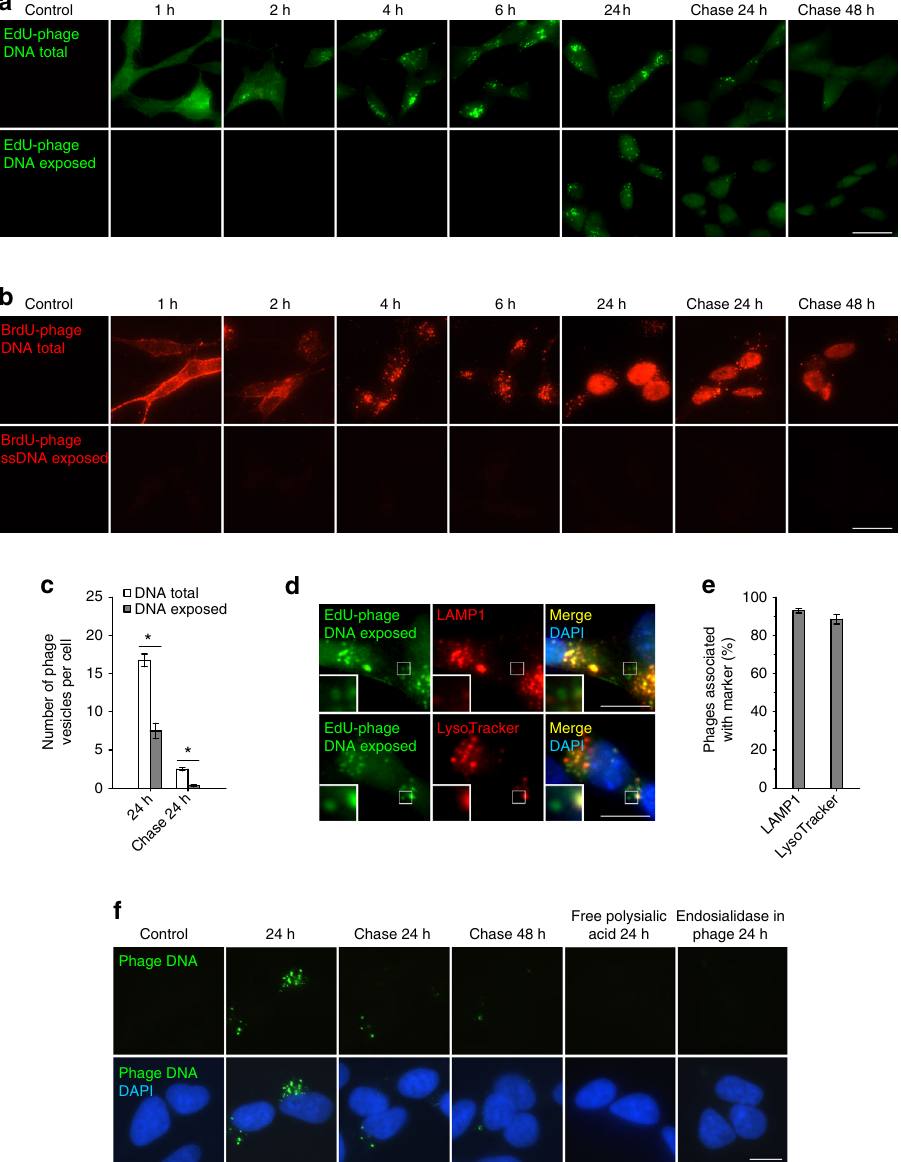
Fig. 6 Time course of the exposure of phage DNA inside the cell. a , b Internalization of DNA-labeled PK1A2 phages into cultured kSK-N-SH cells at 37°C. EdU ( a ) or BrdU ( b ) labeled phages (green and red, respectively) were detected under the conditions showing total DNA or exposed DNA as described in Methods. EdU staining reveals DNA irrespective of strand form, the BrdU method reveals DNA in single-strand form. Representative images from three biological replicates are shown. c Quanti fi cation of phage vesicles positive for EdU at 24h and after subsequent chase for 24h (each vesicle may contain several phage particles). At least 100 cells were quanti fi ed for each condition. Results are expressed as mean ± s.d. of three independent experiments. The asterisks mark P -value of < 0.005 as calculated by Student ’ s t -test. d Association of EdU-labeled phage clusters with lysosomal compartments. The cells were incubated with phages (green) for 24h at 37°C to reveal exposed phage DNA and LAMP1 (red) or LysoTracker (red) as in Figs. 4b and 6a. Nuclei were stained with DAPI (blue). Representative images from two biological replicates are shown. e Quanti fi cation of EdU-labeled phage vesicles positive for LAMP1 or LysoTracker at 24h in d . At least 300 vesicles were analyzed for each condition and the data represent the mean ± s.d. of two independent experiments. f Detection of internalized phage DNA by fl uorescence in situ hybridization (FISH). kSK-N-SH cells were incubated with phages in the absence or the presence of free polysialic acid or with control phages containing active endosialidase at 37°C for the times indicated. The samples were processed for in situ hybridization using Alexa Fluor 488-labeled DNA probes covering the phage genome (green). Nuclei were stained with DAPI (blue). Representative images from three biological replicates are shown. The scale bars represent 20 µ m in a and b , 10 µ m in d and f , the insets have been enlarged fraction of the particles with exposed DNA seemed not to be associated with these compartments (Fig. 6d, insets).